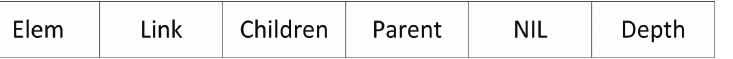
Figure 3. The expanded node